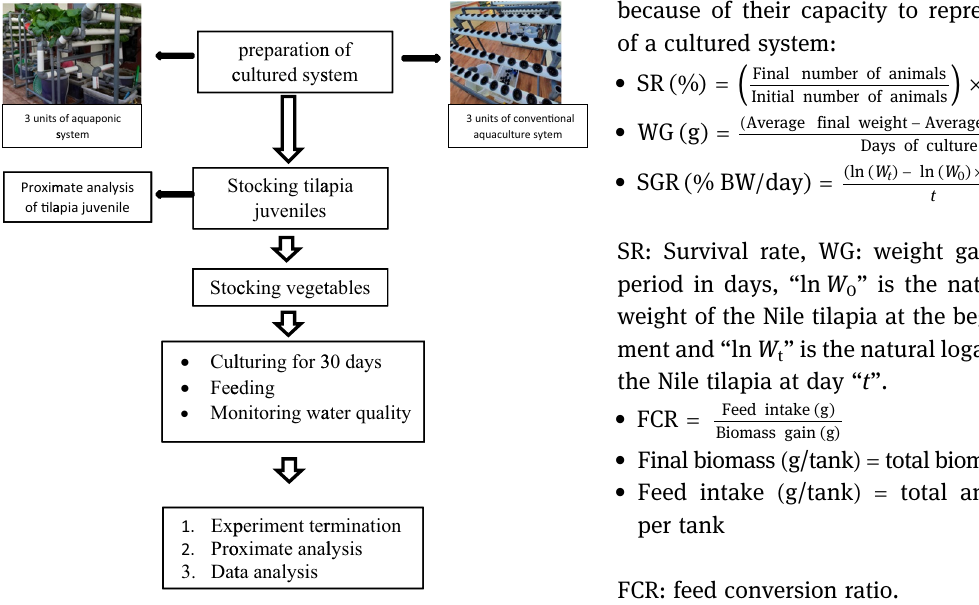
Figure 2: Flowchart of the experiment started from the preparation of cultured systems until experiment termination and data